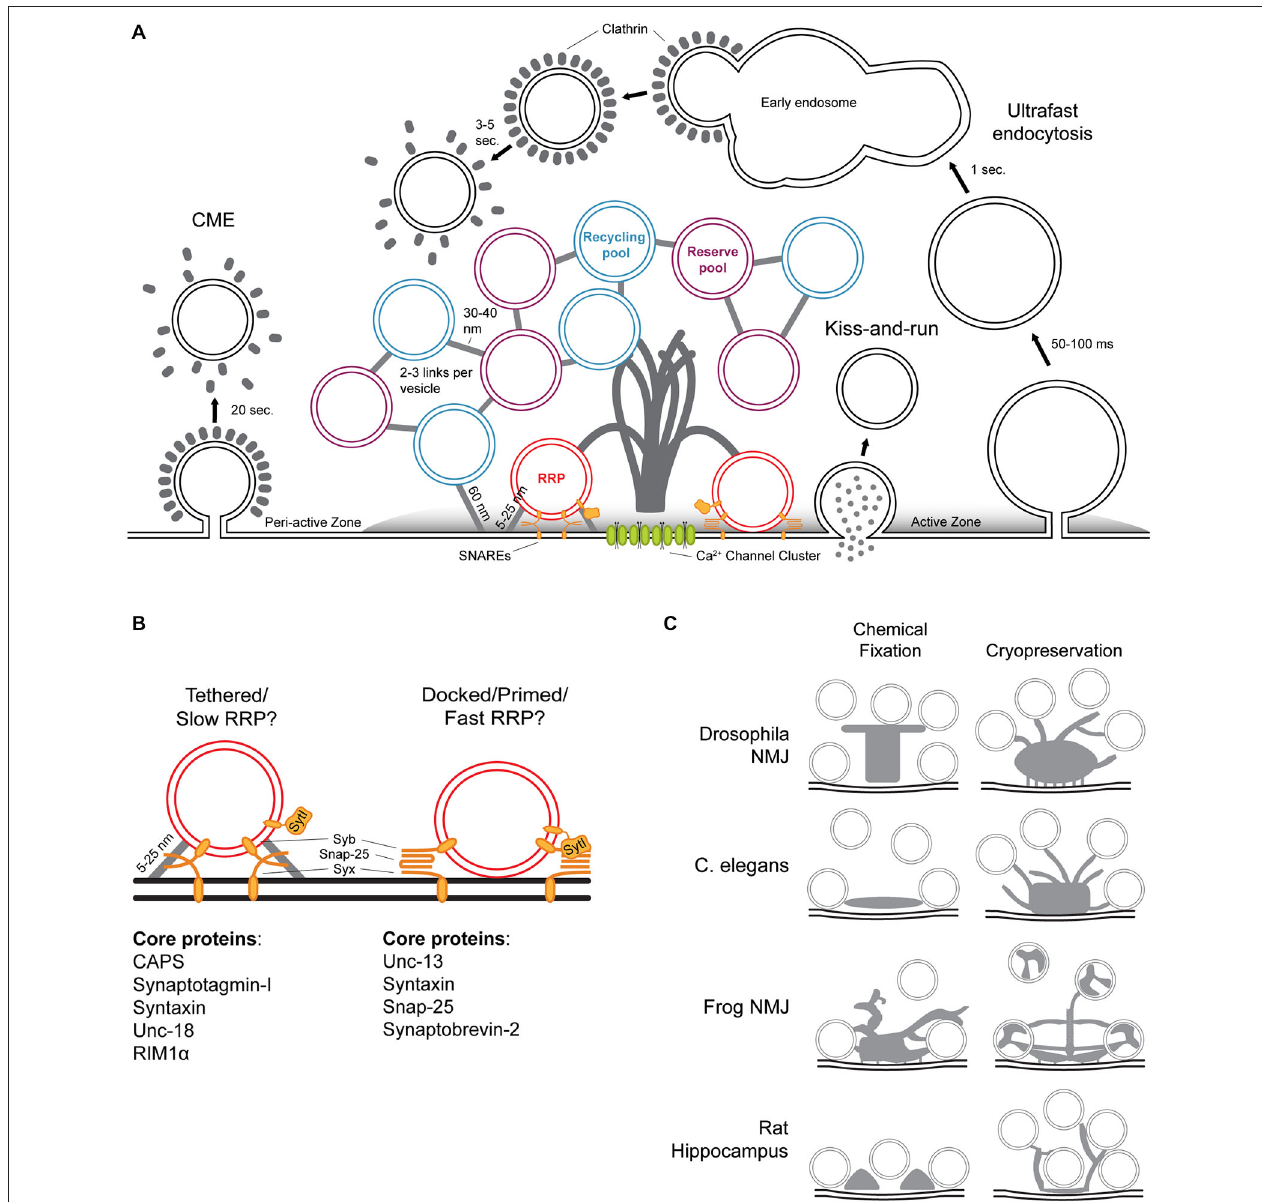
SVs following exocytosis: clathrin-mediated endocytosis (CME), kiss-and-run, and ultrafast endocytosis. The newly described ultrafast endocytosis involves the formation of 80-nm diameter vesicular intermediates within 50–100 ms after stimulus that fuse with early endosomal compartments within 1 s after stimulus. SVs are then reformed from the early endosome in a clathrin-dependent manner 3–5 s post stimulus. (B) The RRP includes SVs tethered to the AZ membrane by short filaments 5–25 nm in length and SVs in direct contact with the membrane. Although the exact molecular composition of SV tethers is unknown, some of the AZ proteins responsible for regulating SV tethering and docking/priming are known. (C) Cryopreservation of synapses reveals the morphological intricacies of dense projection structure previously masked by chemical fixation and dehydration. Although the unique functional requirements of distinct synapses within and between species likely underlie observed differences in morphology, most Dense projections (DPs) comprise a central core and radiating filaments of varying lengths that contact of distinct functional